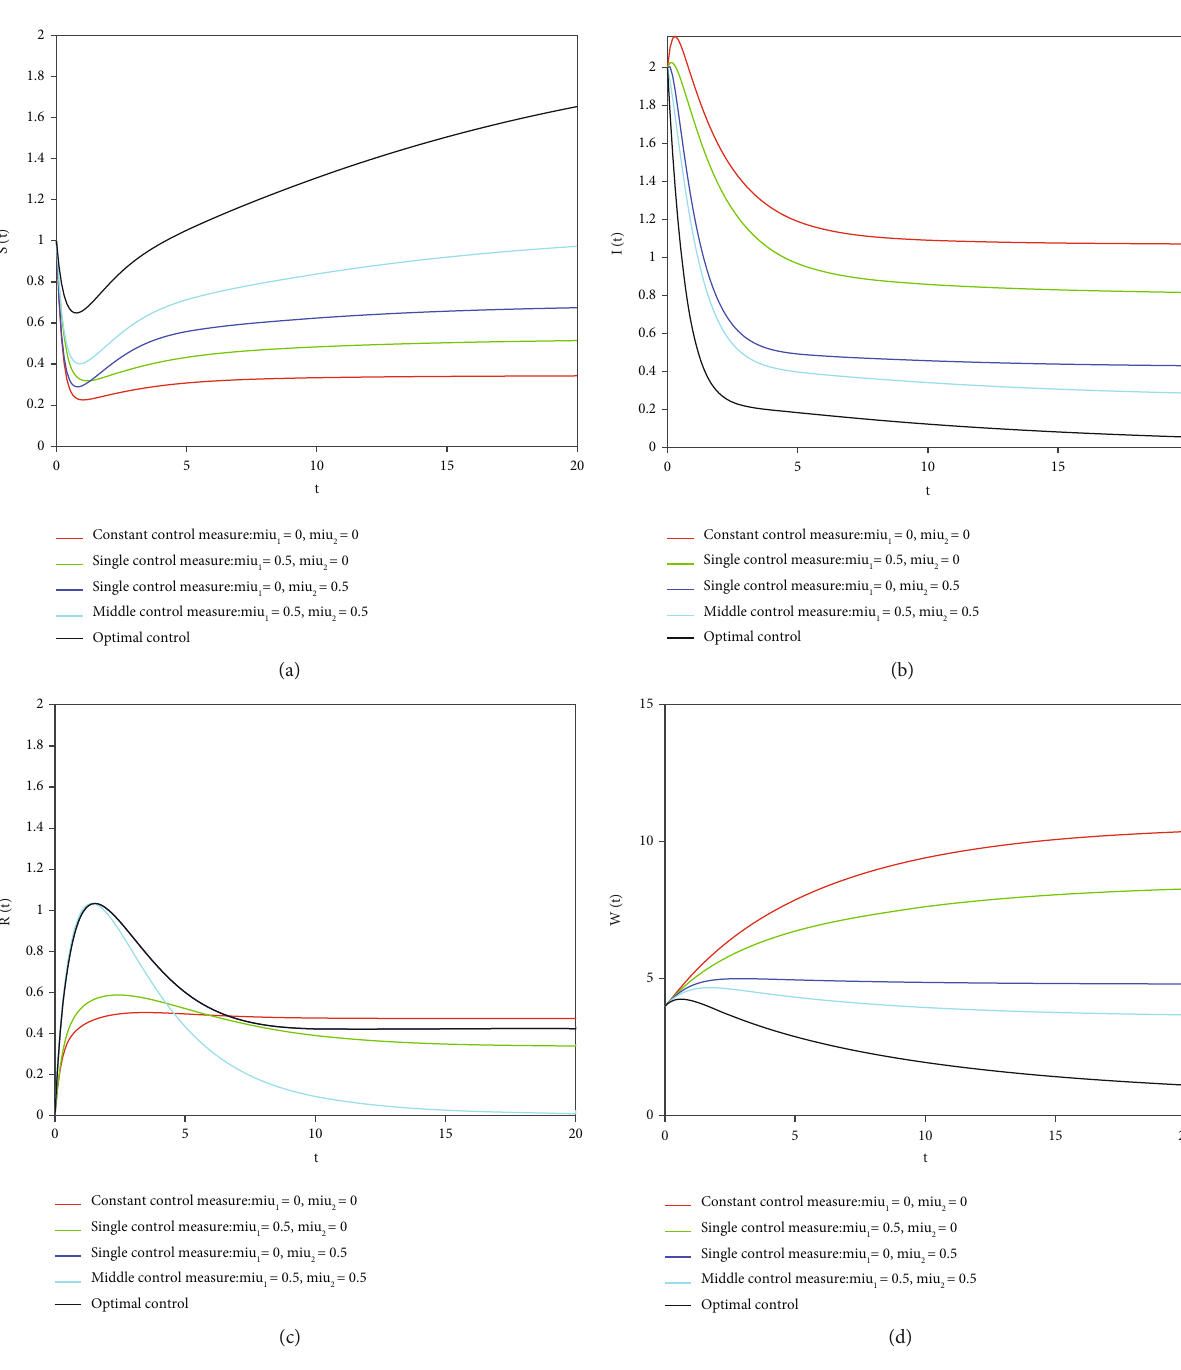
Figure 5: Corresponding S ð t Þ , I ð t Þ , R ð t Þ , and W ð t Þ curves under di ff erent control strategies. (a) means corresponding S ð t Þ curves under di ff erent control strategies; (b) means corresponding I ð t Þ curves under di ff erent control strategies; (c) means corresponding R ð t Þ curves under di ff erent control strategies; and (d) means corresponding W ð t Þ curves under di ff erent control